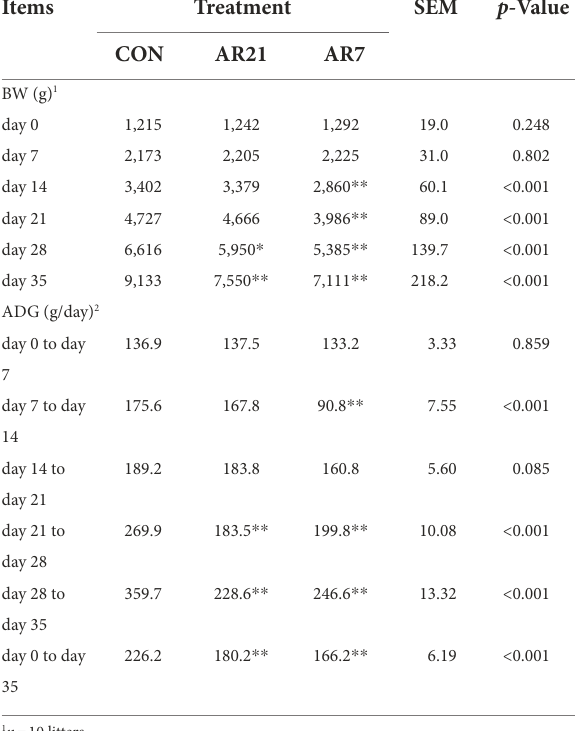
TABLE 1 Effect of artificial rearing on growth performance of